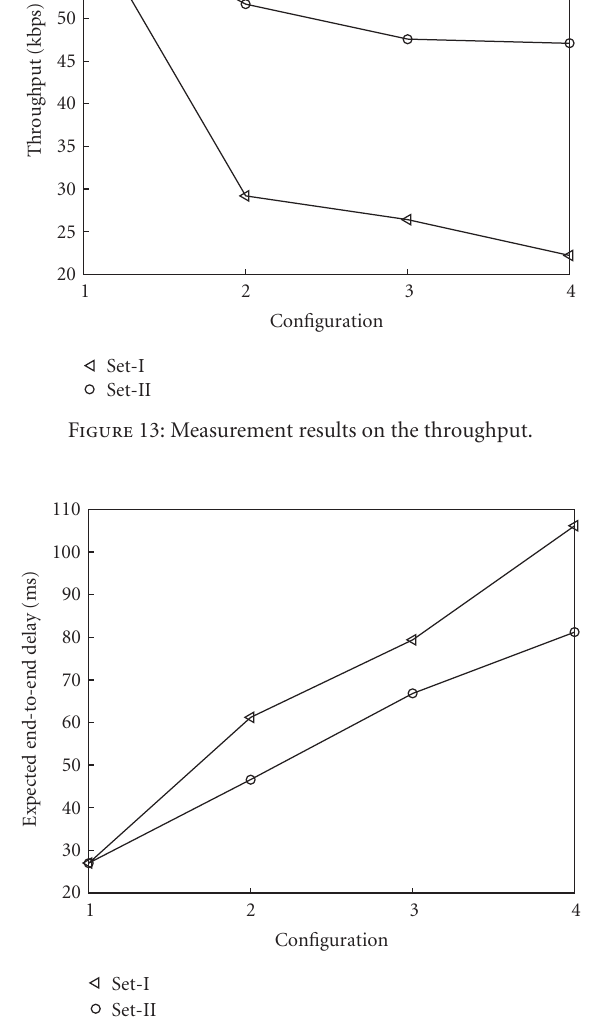
Figure 14: Measurement results on the expected end-to-end packet